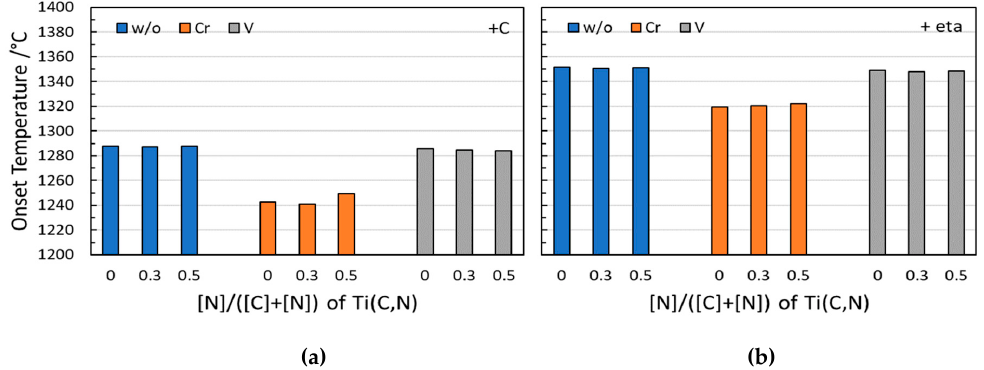
Figure 5. Liquid phase formation temperature of the 18 grades of hardmetals, each with free C and free eta phase; w/o: without doping, Cr: with Cr doping, V: with V doping. ( a ) peak onset temperature of grades with free C, ( b ) peak onset temperature of grades with eta phase.